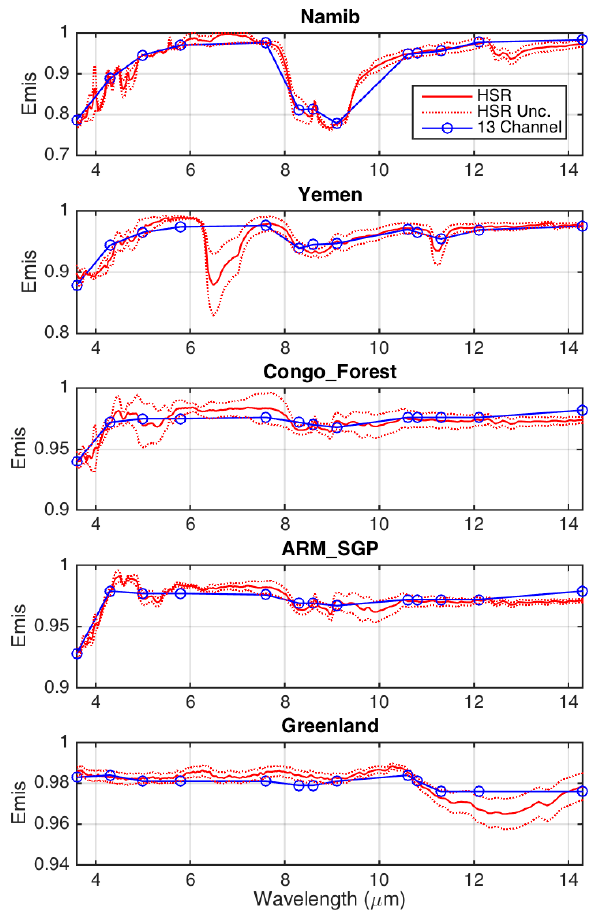
Figure 1. CAMEL emissivity for the 13 hinge points (blue open circles), 417 HSR channels (red line), and HSR uncertainty (red dotted lines) for January 2004 over the (from the top to bottom panel) Namib Desert (quartz), Yemen (carbonates), Congo (forest), Atmospheric Radiation Measurement Southern Great Plains (mixed agriculture), and Greenland (ice/snow) sites. Note changes in y -axis limits between panels.